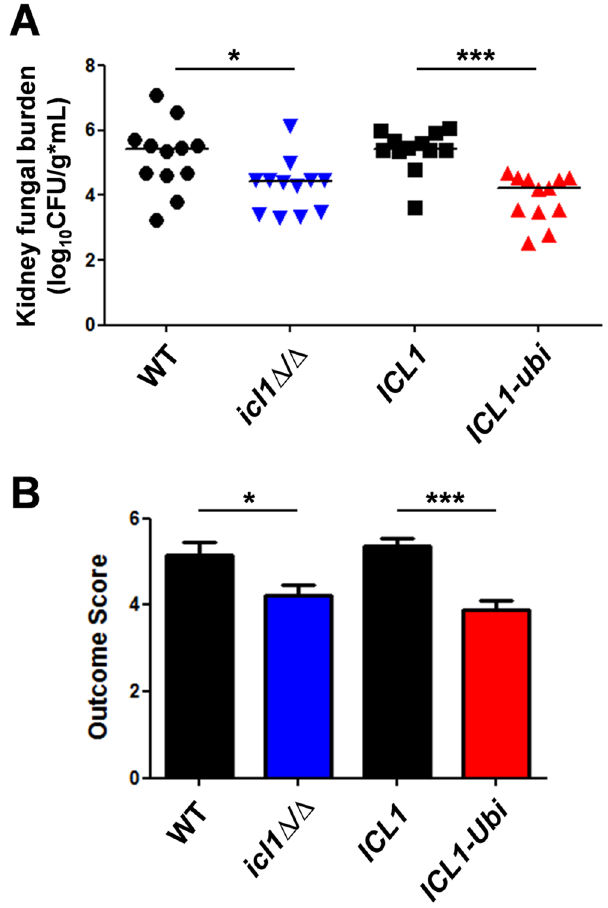
Fig 6. Metabolic flexibility in C . albicans promotes systemic infection. BALB/c mice were injected via lateral tail vein with the following C . albicans strains (n = 12 per group): WT, SC5314; icl1 Δ / Δ , DCY65; ICL1 , DCY75 ( ICL1-Myc 3 -NAT1 ); ICL1-Ubi , DCY82 ( ICL1-UbiMyc 3 -NAT1 ) (S2 Table in the supplementary information). (A) Renal fungal burdens after 72 h. Points indicate CFUs recovered from each animal and the bar denotes the mean. (B) Infection outcome scores measured after 72 h using the renal fungal burden combined with the percentage weight change for the mice ± SEM [39]. Statistical analyses were done by the Mann-Whitney U test using Prism 5: * , P (cid:1) 0.05; ** , P (cid:1) 0.01; *** , P (cid:1)